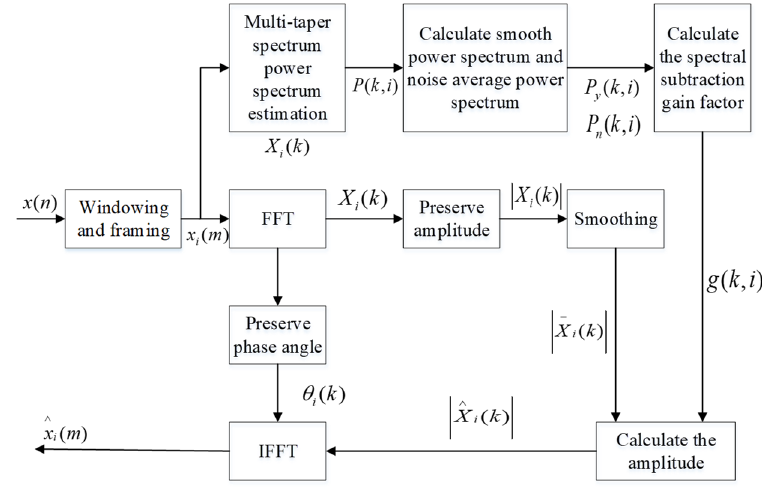
Figure 2. Schematic diagram of Improved Spectral Subtraction.